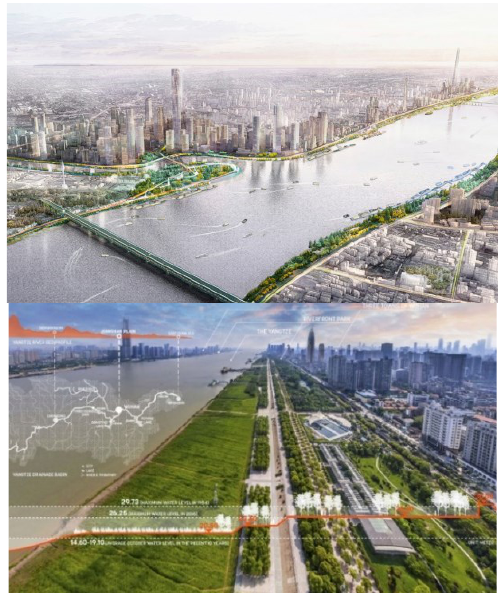
Figure 7. The Riverside renders for both sides and the closer rendering of the